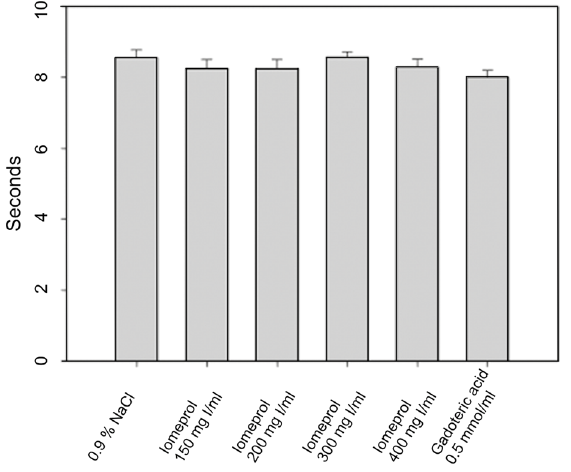
Figure 3. Times required for injection (3.4 ml/min) of 450 m l of different pre-warmed (37 6 C) contrast agents via the self constructed vascular access mini-port. Despite different concen- trations (and thus viscosities) of the contrast agents, no relevant delay of infusion speed compared to a physiological saline solution was observed and no leakage from the VAMP was